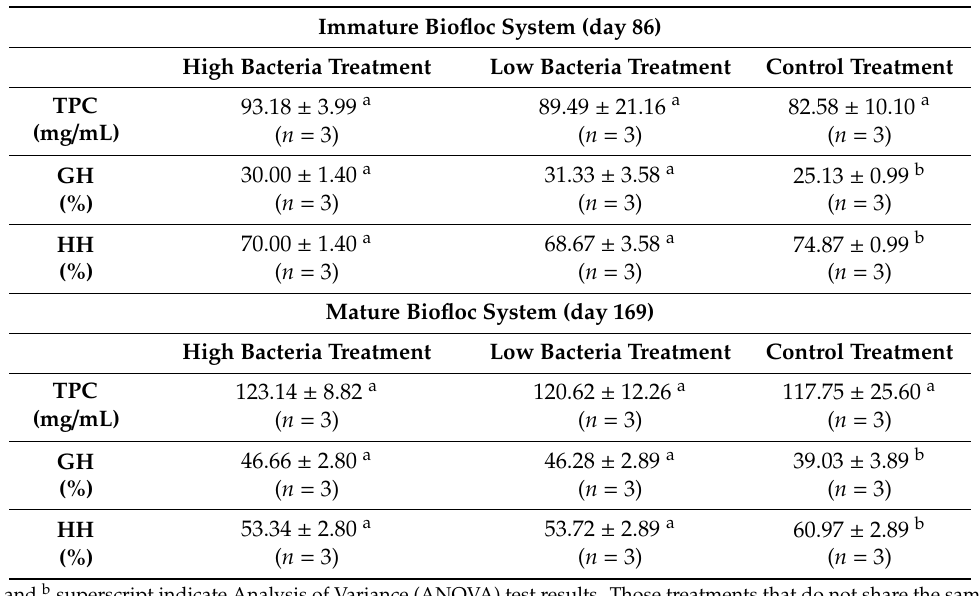
Table 3. Average and standard deviation of immune system parameters (total protein concentration (TPC), granular hemocytes (GH) and hyaline hemocytes (HH)) in di ff erent stages of Biofloc technology (BFT) evolution (immature and mature BFT) for high bacteria treatment (2.8 × 10 4 cfu / mL), low bacteria treatment (2.8 × 10 3 cfu / mL) and control treatment. The n values are indicated for each